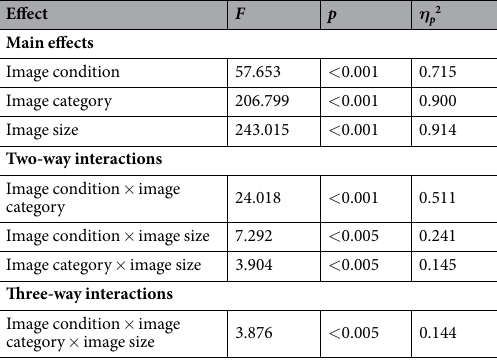
Table 8. Results of the 2 × 3 × 5 (image condition × image category × image size) ANOVA for fixation